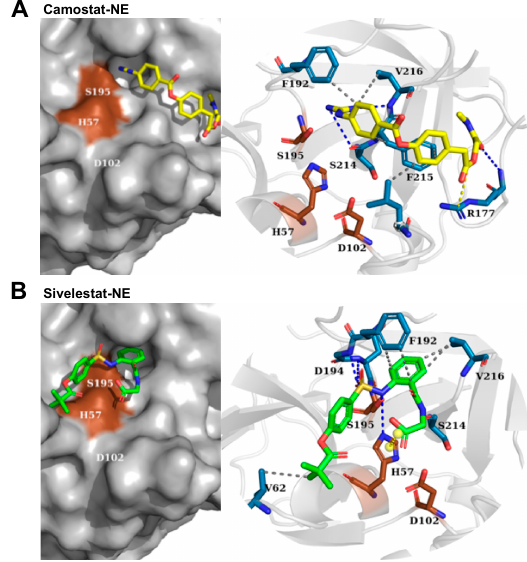
Figure 4. Binding poses of camostat and sivelestat at the catalytic center of NE. Camostat (yellow) and sivelestat (green) were simulated for binding to the catalytic center of NE (1B0F). ( A ) Predicted amino acid residues forming three hydrogen bonds (R177, S214, and V216), three hydrophobic (F192, F215, and V216), and one salt bridge (R177) between camostat and NE. ( B ) sivelestat possesses six hydrogen bonds including H57, G193, D194, S195, and S214, five hydrophobic including V62, F192, and V216, and one salt bridge (H57) with NE. The catalytic triad (brown) within the surface model of NE (grey) and blue dashed lines refer to hydrogen bonds. Hydrophobic interactions and salt bridges are represented by grey- and yellow dashed lines, respectively.